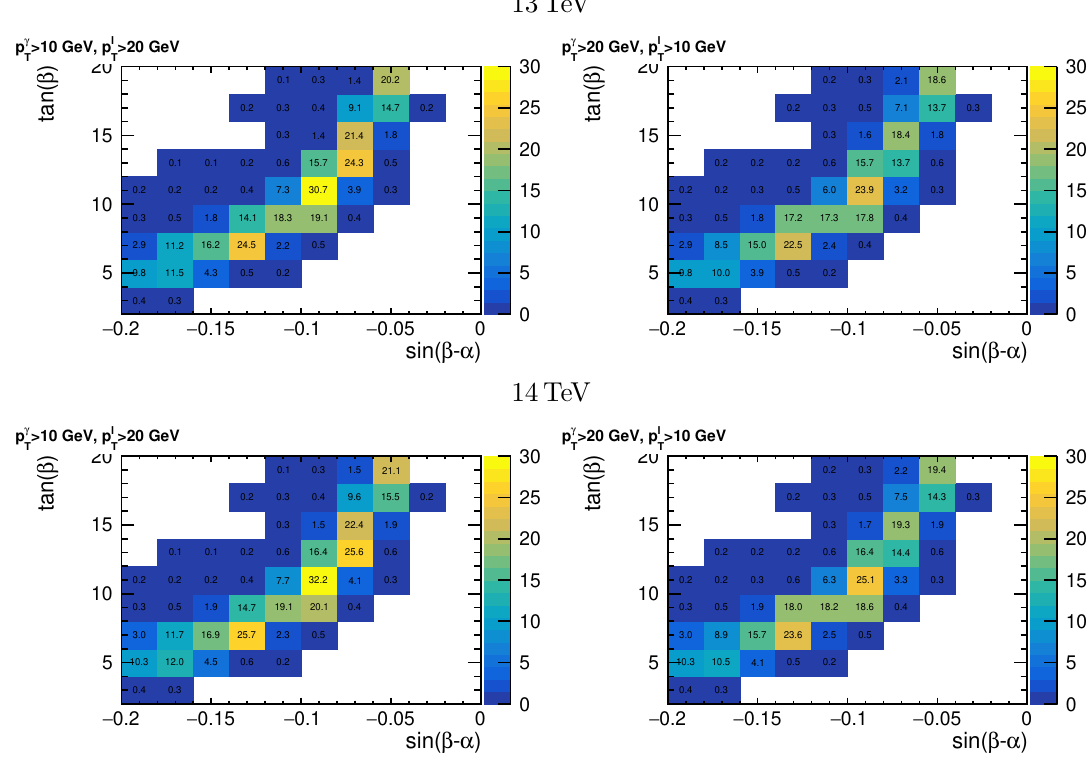
Figure 7 . The predicted significances over the ( sin( β − α ) , tan β ) plane for the two sets of cuts given in eqs. (3.4) (left) and (3.5) (right), when and L = 300 fb − 1